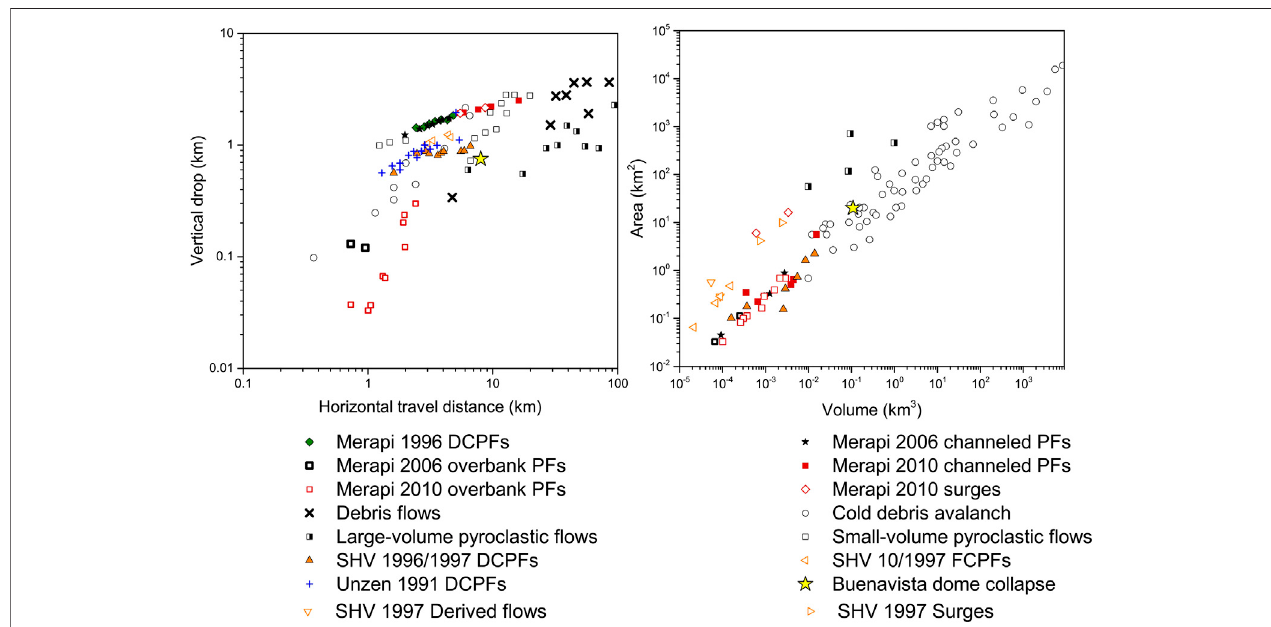
FIGURE 14 | Comparison between various types of fl ows of dome collapse origin (DCPFs), PFs, debris fl ows, and cold debris avalanche deposits (from Merapi volcano, Unzen volcano, Soufriere Hills volcano (SHV) and others) with regard to vertical drop over horizontal distance traveled (H/L), and Area (km 2 ) vs Volume (km 3 ). Buenavista data are represented with a yellow star, and are located within spaces represented by dome collapse block and ash fl ows, small-volume pyroclastic fl ows and cold debris avalanches. Modi fi ed from Charbonnier et al. (2013).